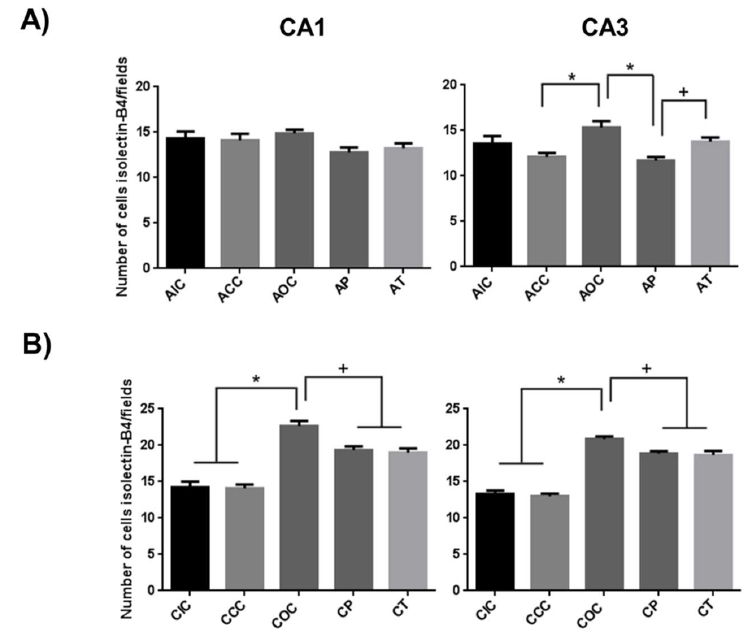
Figure 5. Effect of CUR is depicted on the total count of microglial cells in the acute and chronic exposure to O 3 . ( A ) The total number of isolectin-B4 positive cells in the acute phase is shown in the graph as mean ± SEM. In both CA1 and CA3 regions, no statistical differences were observed after 15 days of exposure. Meanwhile, the total microglial cell count was reduced in the AP group due to CUR. ( B ) The total isolectin-B4 positive microglial cells in the chronic phase are shown. The cell count increased in the group exposed to O 3 . In contrast, CUR decreased the total number of microglial cells in CP and CT groups in both hippocampal regions. * p < 0.001, + p < 0.01.